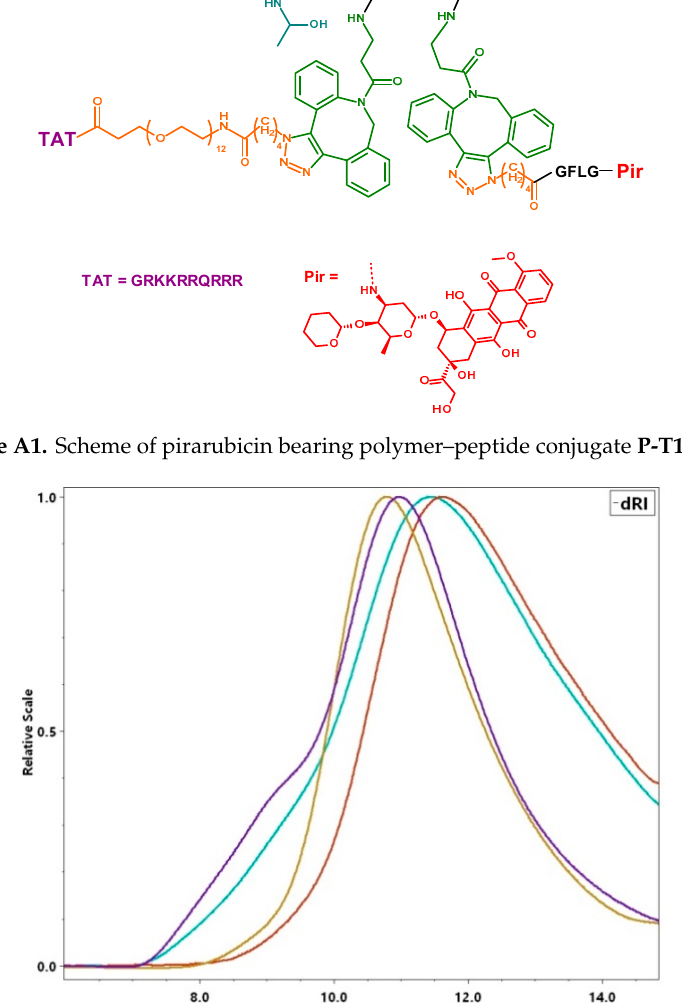
Figure A3. ( A ) Example of histogram of live HeLa cells incubated with Sytox Blue Dead Cell Stain for 5 min. ( B ) Histogram of HeLa cells incubated first with 100 μ M concentration of TAT4 or PEN4 polymer conjugates for 1 h and then with Sytox Blue Dead Cell Stain for 5 min. Live and dead cell populations correspond to peaks at fluorescence values 102 and 104, respectively. Cells were analyzed with a 405 nm violet diode laser and a 440 nm bandpass filter. ( C ) Dot plot with typical gating of live cell population. ( D ) Example of histogram obtained from Flow cytometry measurements of HeLa cells incubated for 1 h with polymer conjugates for REF (blue), TAT4 (green), PEN4 (orange) in concentration 10 μ M and cells alone (red) at 4 °C.